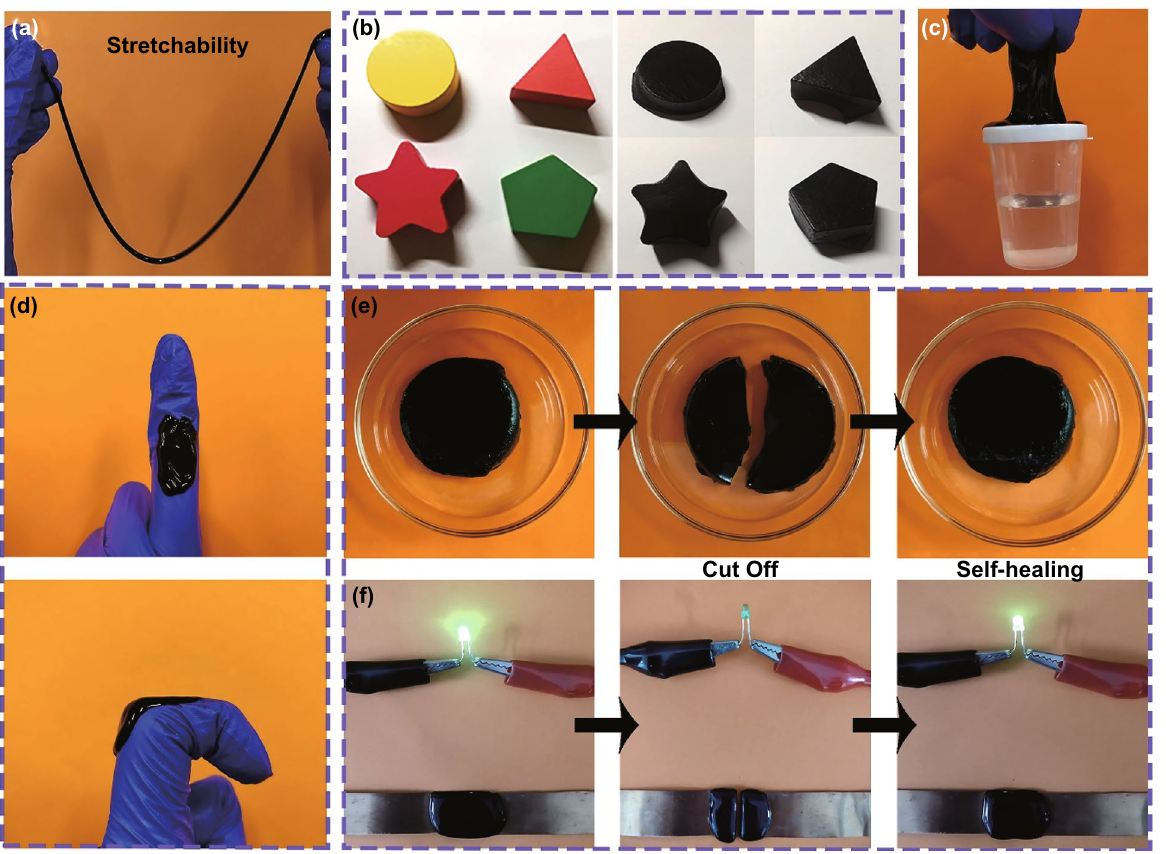
Fig. 2 Photographs showing the a stretchability, b shape adaptability, c, d adhesiveness and e, f self-healing function of MXene